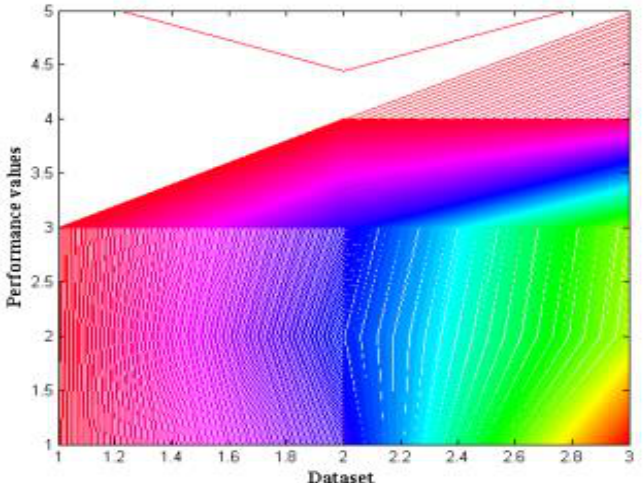
Figure 12. Overall performance analysis.